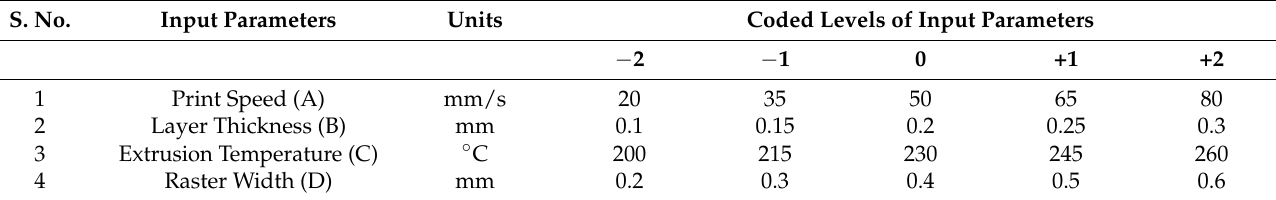
Table 1. Working levels of input